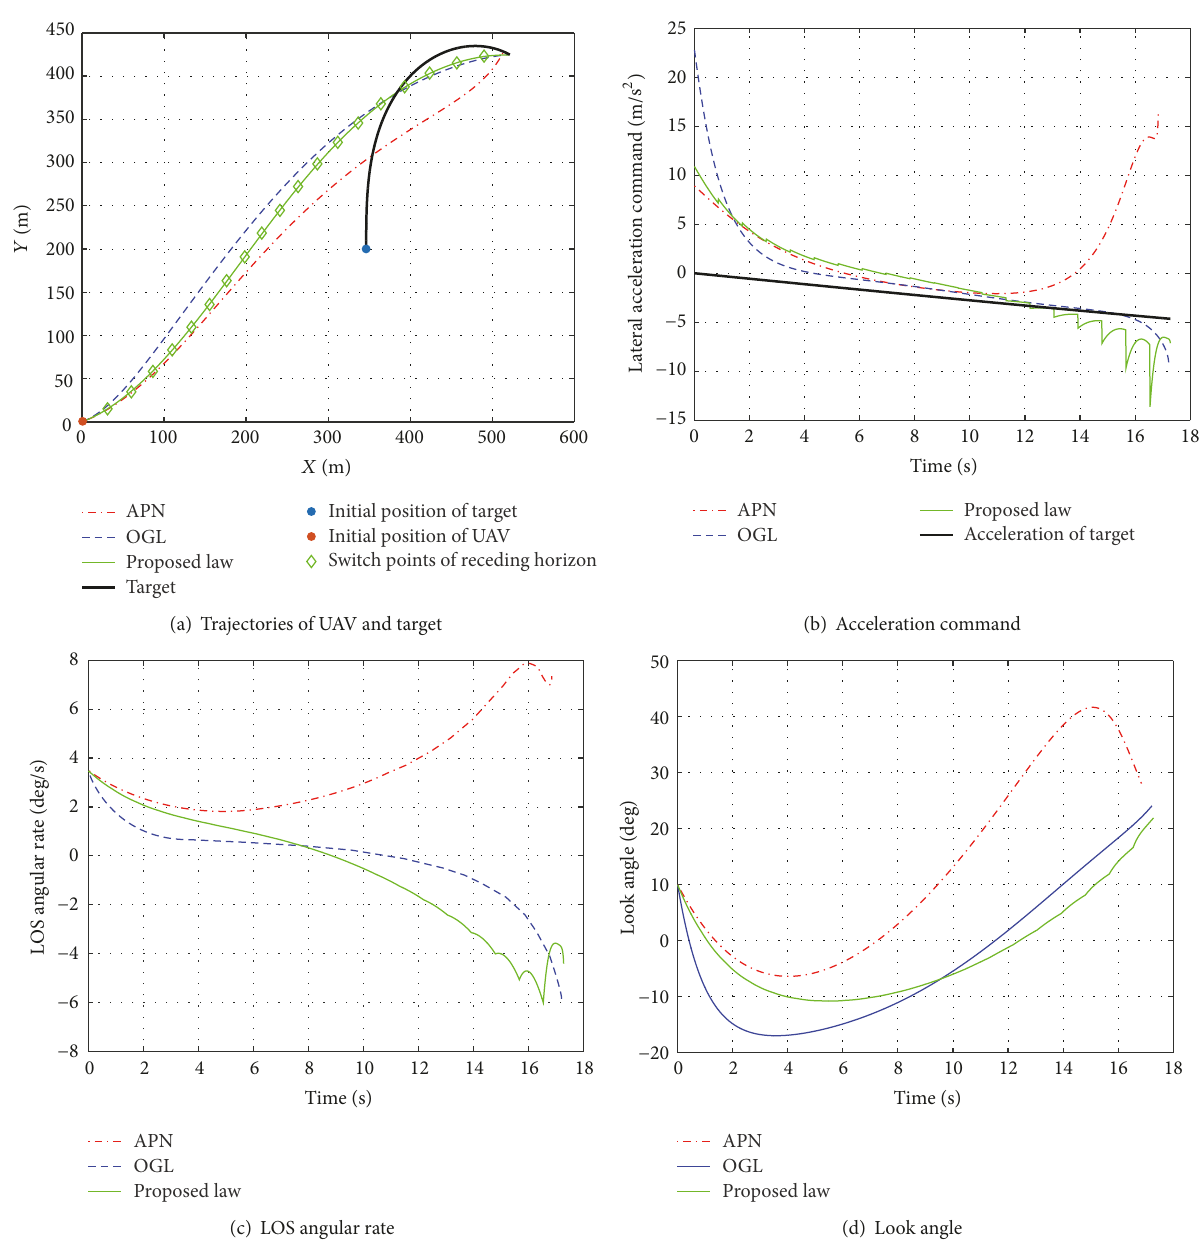
Figure 14: Responses in Case 2 (𝑎 𝑇 = −10 sin (0.02𝑡))